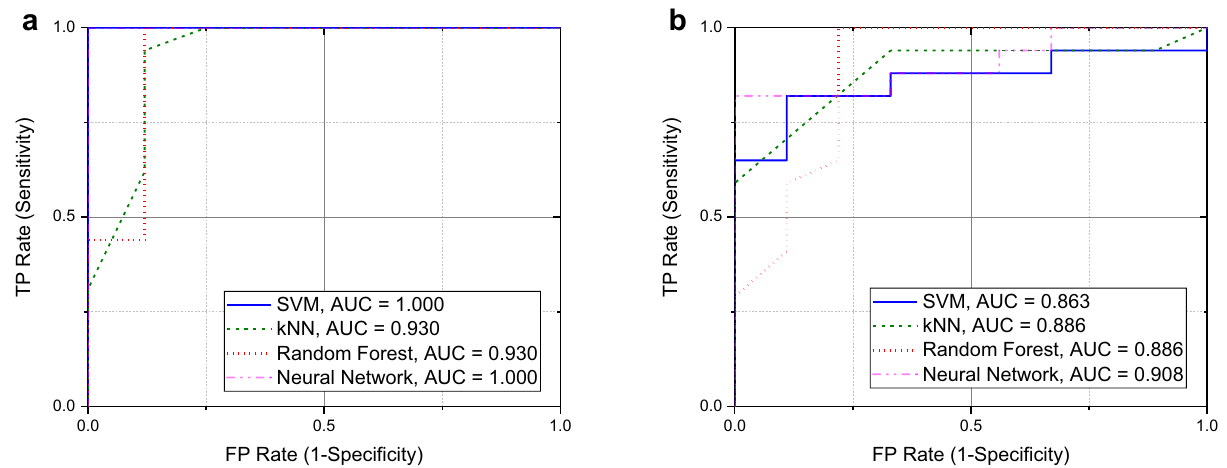
Figure 6. ROC curves observed for the examined cohort of ( a ) 24 samples (16 COVID-19-infected patients over 55 years old, 8 healthy volunteers over 45 years old), and ( b ) 26 samples (17 COVID-19-infected patients under 55 years old, 9 healthy volunteers under 45 years old). Four selected detection algorithms were considered: SVM, kNN, Random Forest, Neural Network. AUC—Area Under the